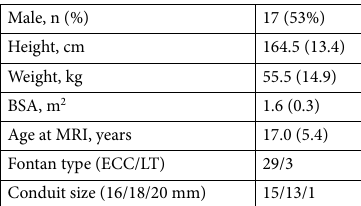
Table 1. Patient characteristics. Values are reported as mean (standard deviation) unless otherwise specified. BSA; body surface area (Haycock), ECC; extracardiac conduit, LT; lateral tunnel, mm; millimeter.